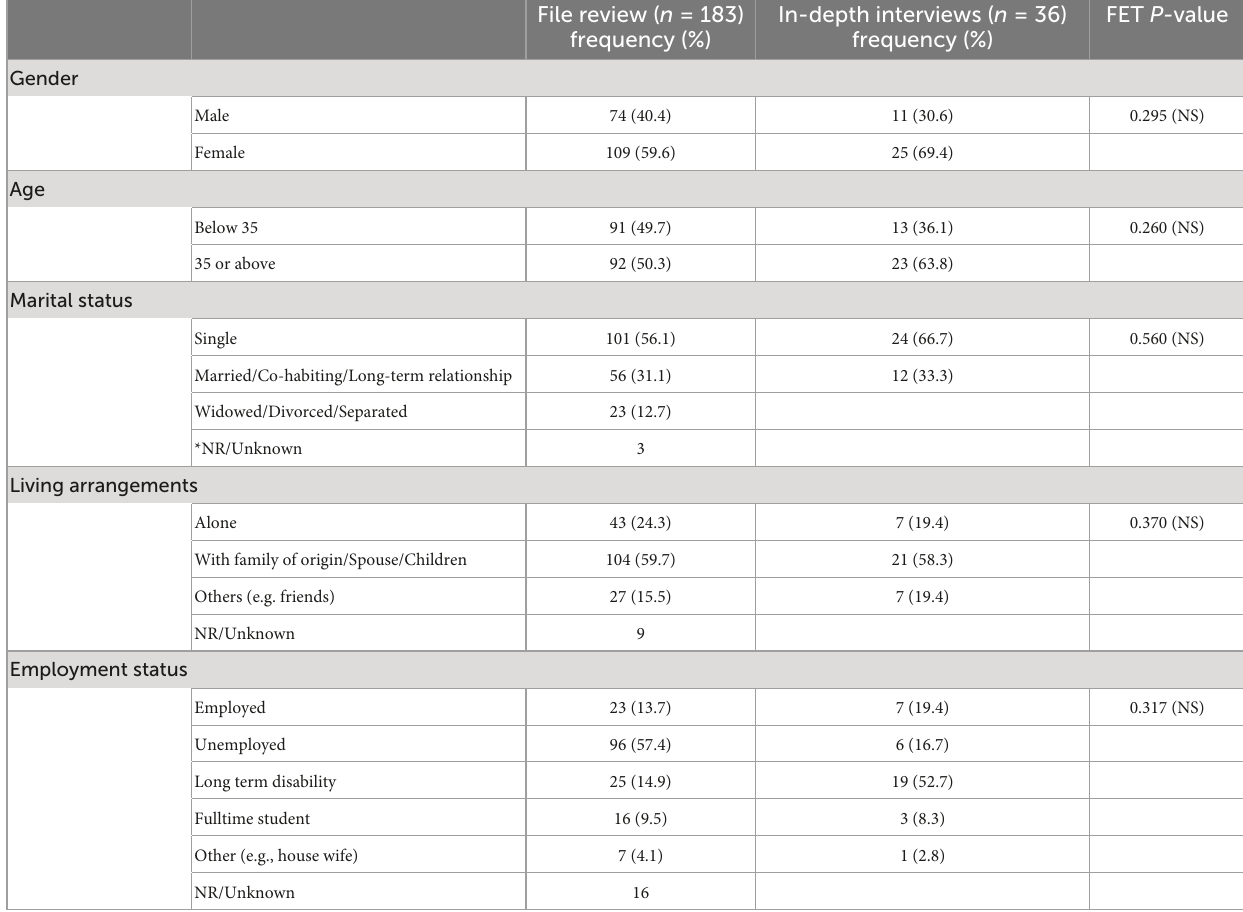
TABLE 1 Sociodemographic and self-harm characteristics of the study